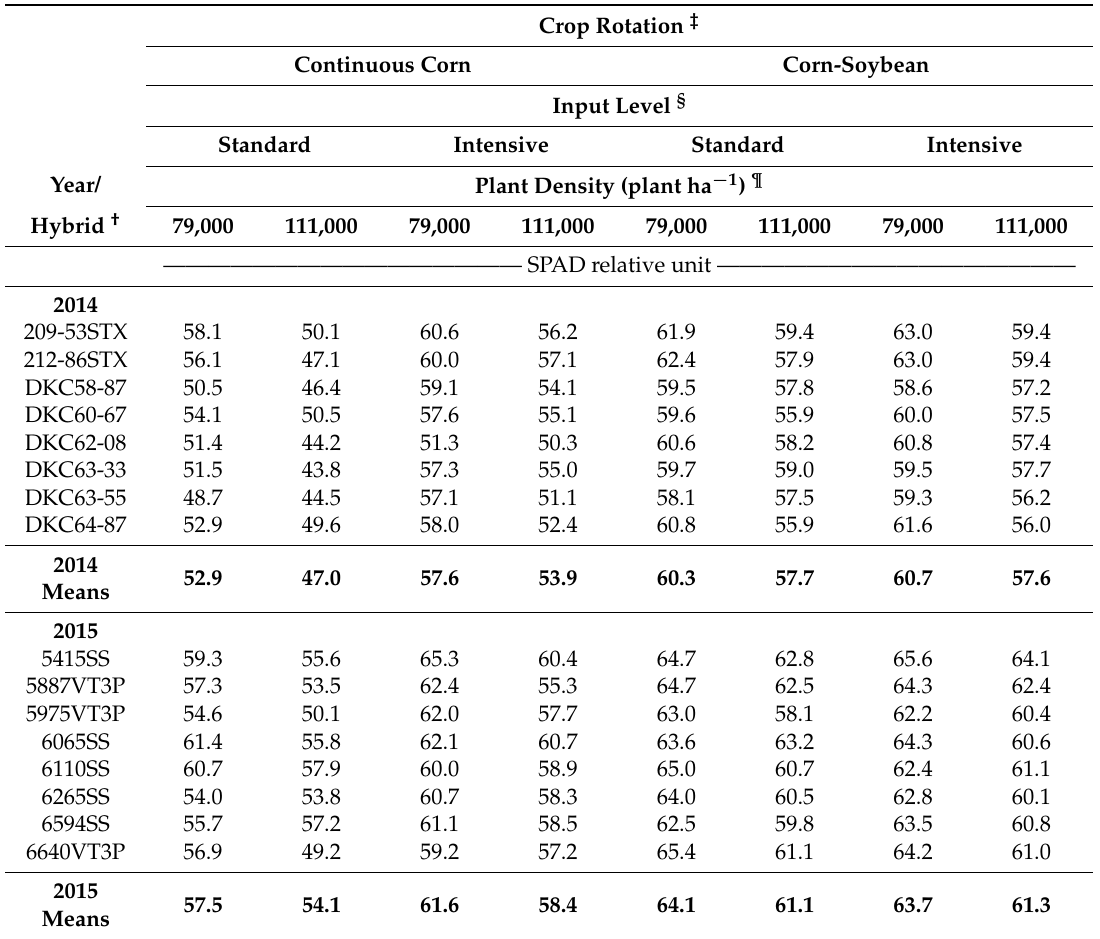
Table 4. Leaf greenness for hybrids as influenced by crop rotation, agronomic input level, and population at the R2 growth stage of the ear leaf. Hybrids were grown in continuous corn and following soybean rotations at Champaign, IL in 2014 and